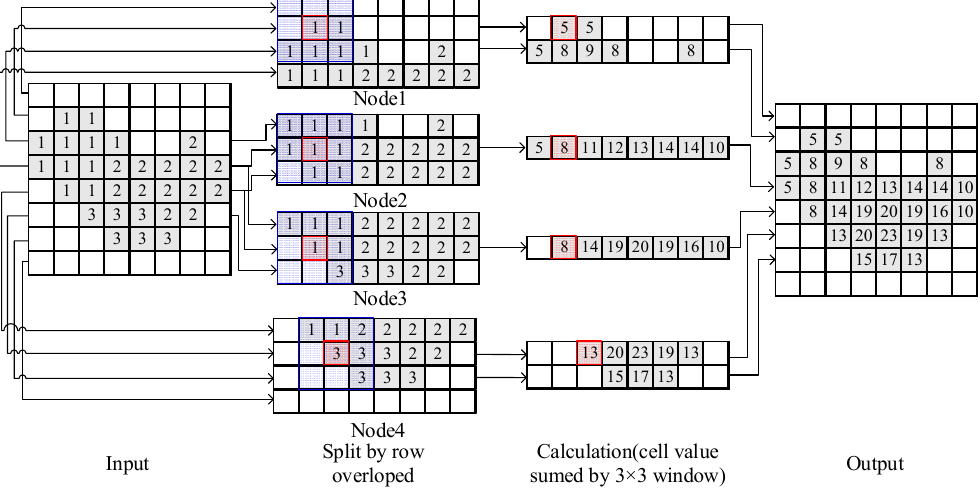
Figure 3. Data overlap splitting by row with 4 calculation nodes. ISPRS Int. J. Geo-Inf. 2019 , 8 , x FOR PEER REVIEW